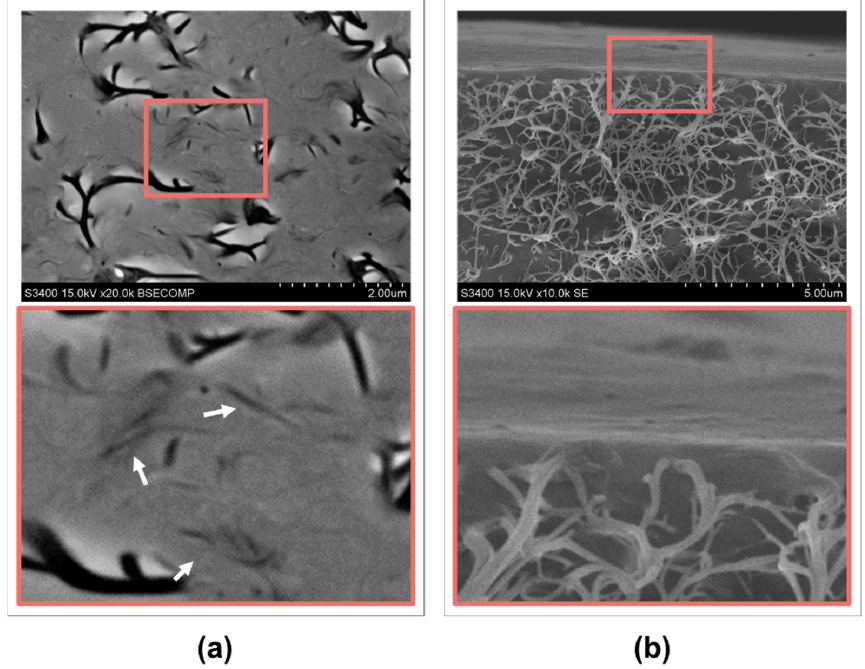
Figure 4. SEM images of nanocomposite surface ( a ) and in the fracture of the sample at the surface ( b ), 20,000 × and 10,000 × magnification, respectively. Arrows indicate individual nanotubes.